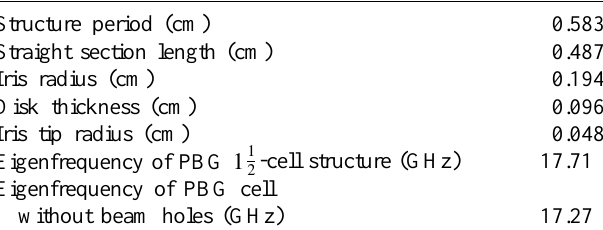
TABLE III. Parameters of the PBG accelerator cell.